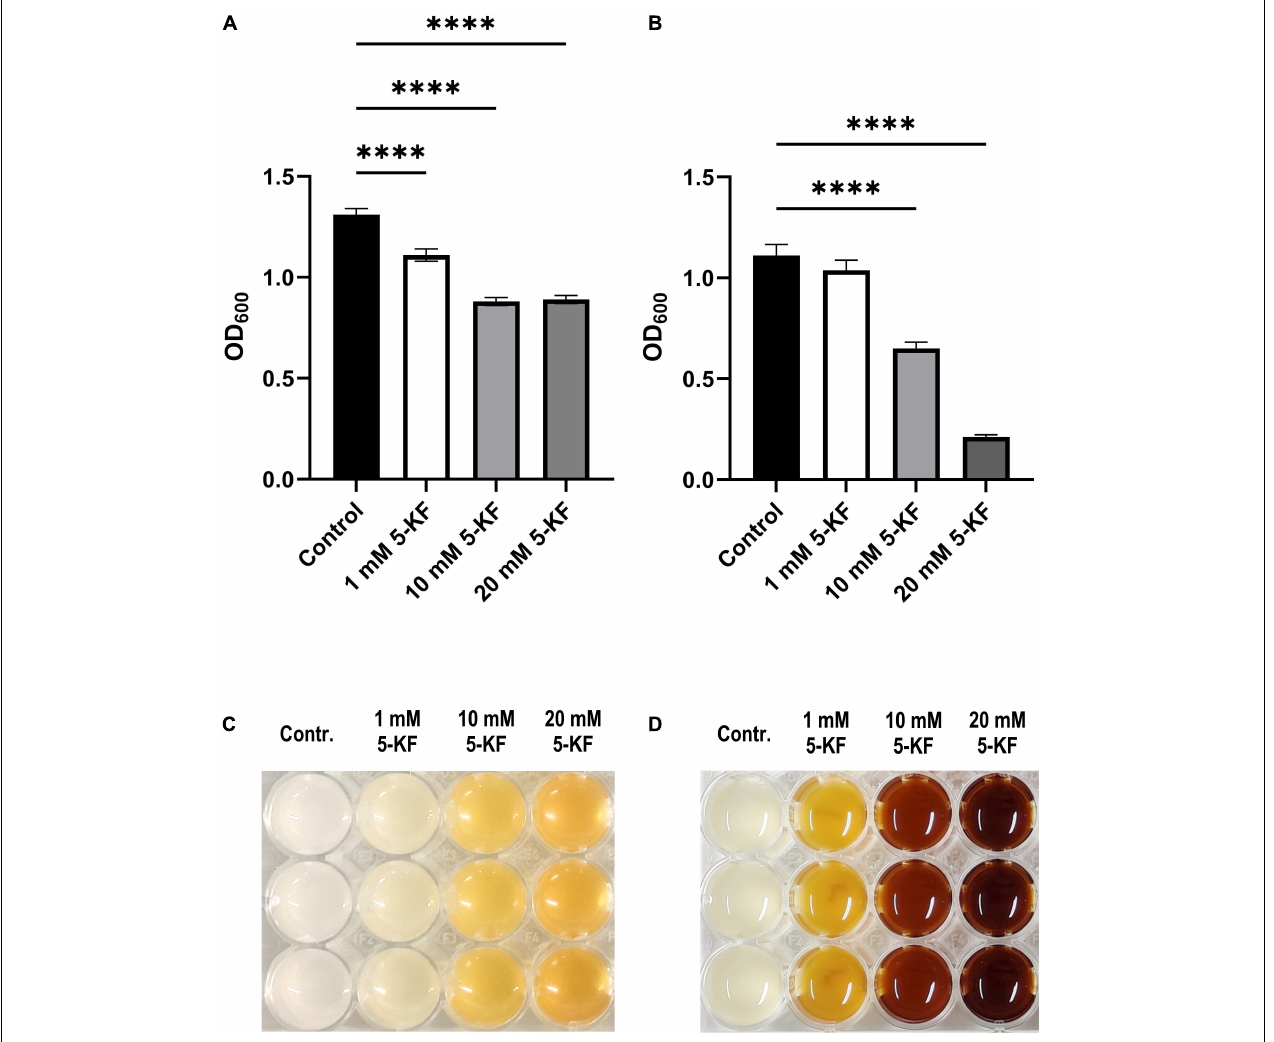
FIGURE 3 | OD 600 values and browning of B. subtilis DSM 10 and E. coli DSM 498 cultures treated with and without 5-KF. B. subtilis DSM 10 was cultured in Spore minimal medium (Demain, 1958) at 30 ◦ C without and with different concentrations of 5-KF (A,C) . OD 600 -values of B. subtilis DSM 10 cultures (A) were subjected to statistical analysis after 28.5 h of incubation when the control culture reached its maximum optical density. B. subtilis DSM 10 cultures were photographed at the end of the experiment after 45 h of incubation (C) . E. coli DSM 498 was grown in modified Wilms-MOPS-medium (Wilms et al., 2001) at 37 ◦ C without and with different concentrations of 5-KF (B,D) . Due to the intense browning, the biomass of E. coli DSM 498 was not accurately detected by the Tecan Infinite M200 plate reader (Tecan Group AG). After 45 h of incubation, E. coli DSM 498 cultures were photographed (D) , harvested, washed twice in buffer W, and subjected to final OD 600 measurement (B) . Dunnett’s multiple comparisons test was performed using GraphPad 9.3.1 (GraphPad Software, San Diego, US) to determine statistical significance; ∗∗∗∗ p < 0.0001. The experiment was performed as a biological